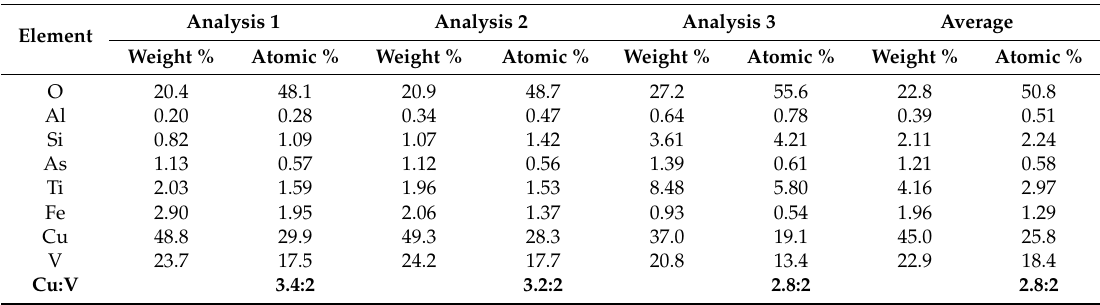
Table 6. SEM/EDS analysis of yellow mineral in colla wood.